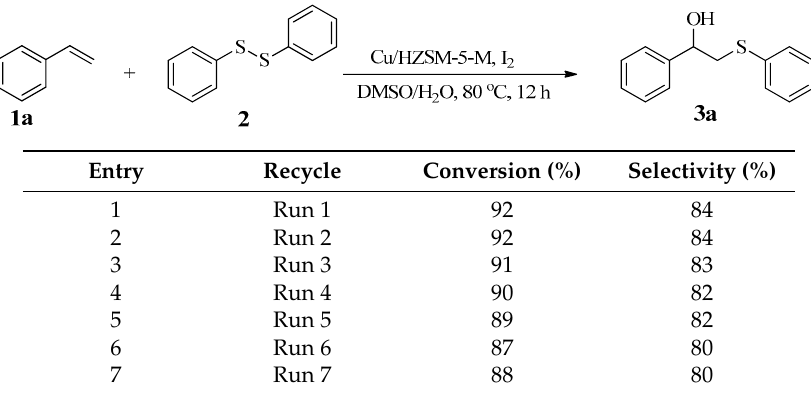
Figure 1. (a) XRD patterns of ZSM-5-M, HZSM-5-M and Cu/HZSM-5-M samples; ( b ) N 2 adsorption isotherms of the ( ■ ) ZSM-5-M and ( ● ) Cu/HZSM-5-M samples. Figure S1: XRD patterns of (a) TS-1-M and Cu/TS-1-M and (b) ETS-10 and Cu/ETS-10 samples; Figure S2. The pore size distributions of the ( ■ ) ZSM-5-M and ( ● ) Cu/HZSM-5-M samples; Figure S3: SEM images of the (a) TS- Table S2: The results of deconvolution of XPS Cu2p3/2 peak of Cu/HZSM-5-M and Cu/TS-1-M samples; Table S3: Optimization of reaction